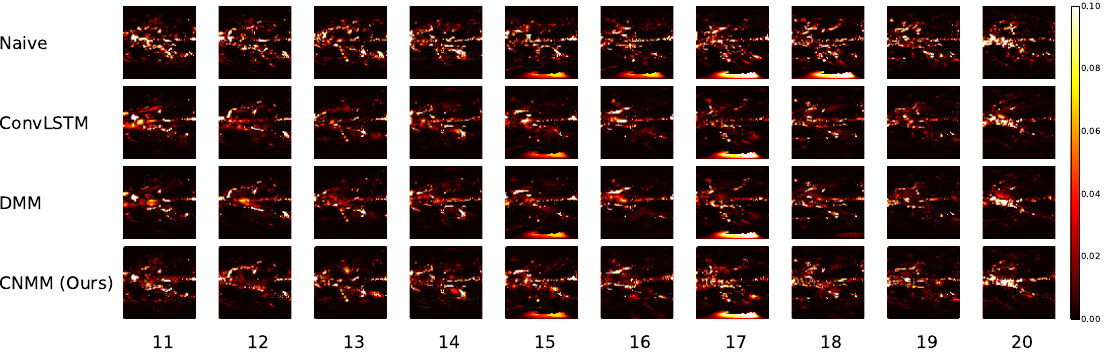
Figure 9. Squared error heatmap between ground truth and predicted forecast of the upper-left data used in the plot shown in Figure 7 (CMAP data). A brighter color means higher error.